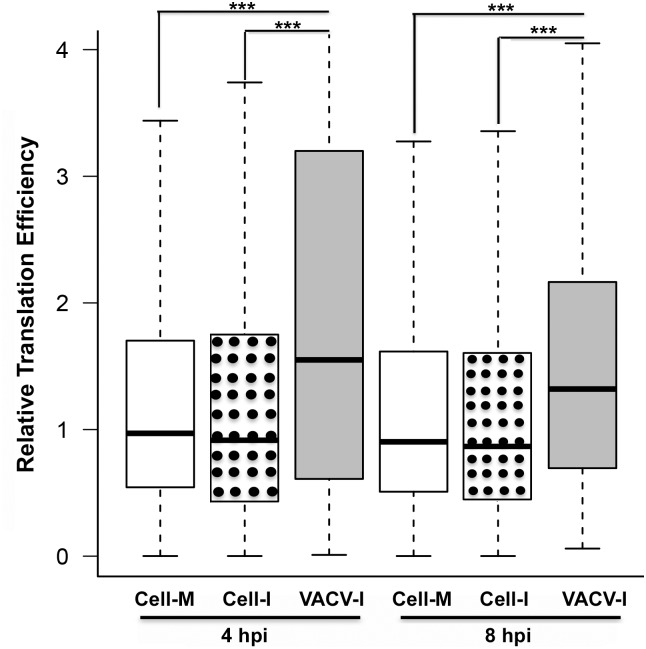
VACV post-replicative mRNAs are more efficiently translated than cellular mRNAs.Boxwhisker plots of relative translation efficiency of VACV post-replicative mRNAs and host mRNAs at 4 and 8 hpi. Relative translation efficiency of mRNAs from uninfected HeLa cells is also shown. The bottom and top of the box indicate the first and third quartiles, respectively, with the line in the middle representing the median. Cell-M, cellular mRNAs from mock-infected cells. Cell-I, cellular mRNAs from VACV-infected cells. VACV-I, VACV mRNAs. The highest relative translation efficiency of VACV-I was off scale. ***indicates a P value < 0.001.